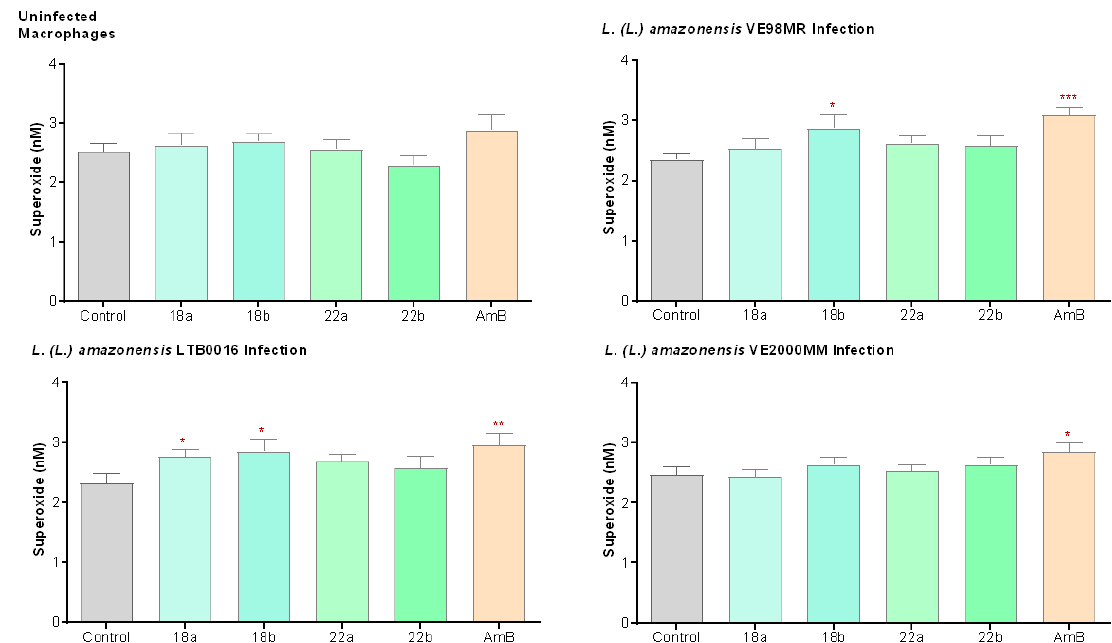
Figure 4. Effect of betulin derivatives on the production of superoxide anion (O 2 − ) by healthy macrophages, or macrophages infected by LTB0016, VE98MR, or VE2000MM, at two increasing concentrations (a and b): 18 (1 and 2 µM), 22 (2 and 4 µM), incubated for 48 h. Each bar represents the average ( n = 3 independent experiments) with its respective standard error (SEM). * p < 0.05; ** p < 0.005; *** p < 0.0005 with respect to the control without treatment. Control: control without treatment; AmB: amphotericin, 0.1 µM.